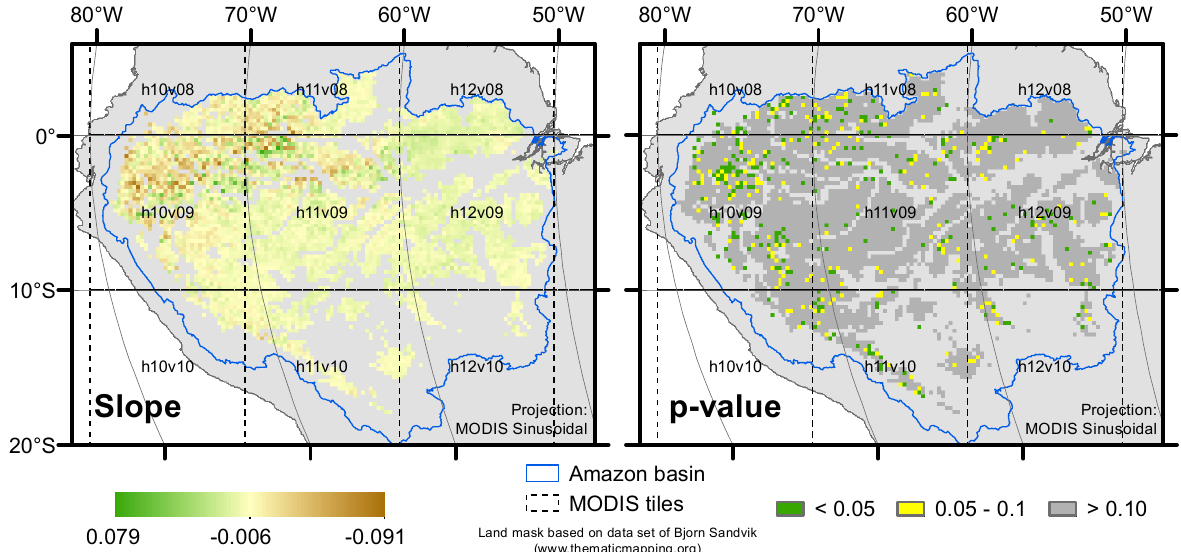
Figure 3: Pixel-based linear regressions of September BRDF-adjusted EVI seasonal anomalies against MCWD on 30 km (~0.25°) spatial resolution.